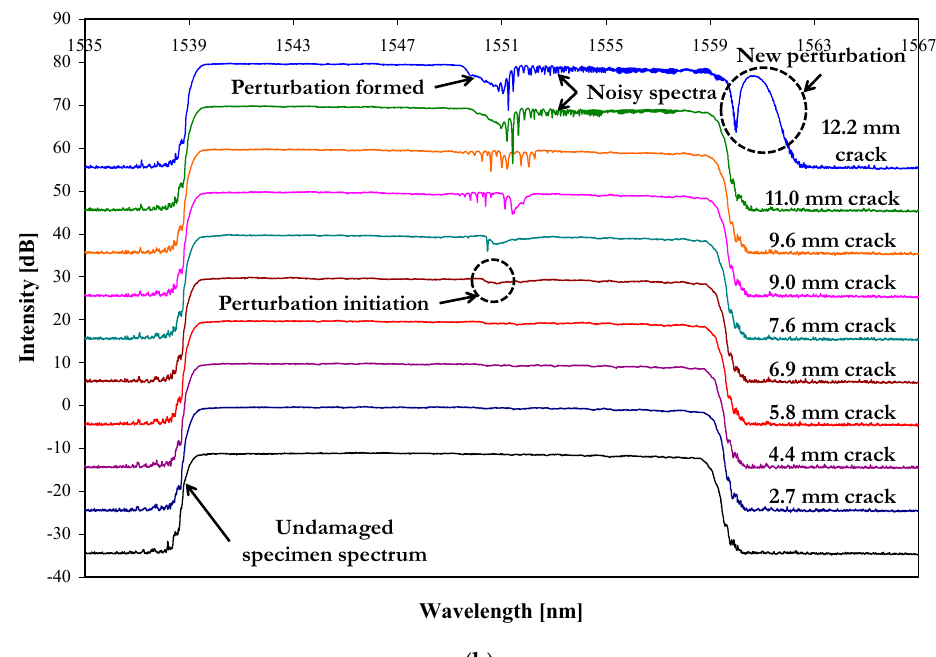
Figure 7. ( a ) Experimentally-recorded reflected spectra for different degrees of damage, from 1.3 mm to 12.7 mm crack length, in specimen 1 (S1) loaded at 6 kN and ( b ) experimentally recorded reflected spectra for different degrees of damage, from 2.7 mm to 12.2 mm crack length, in specimen 2 (S2) loaded at 6 kN.